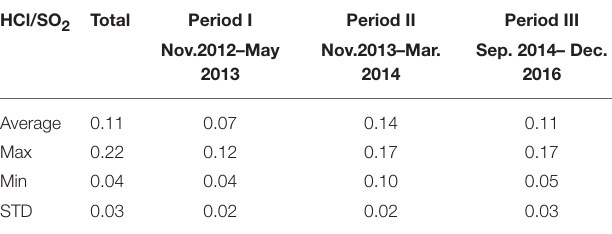
TABLE 2 | Statistics of the HCl/SO 2 molecular ratios measured in the Popocatépetl plume over the 4-year record. HCl/SO 2 Total Period I Period II Period